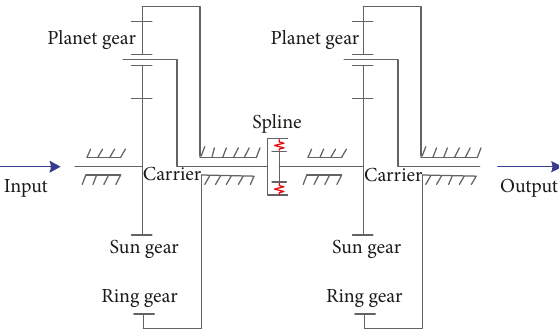
Figure 2: Scheme of two-stage planetary gear with standstill ring gears.